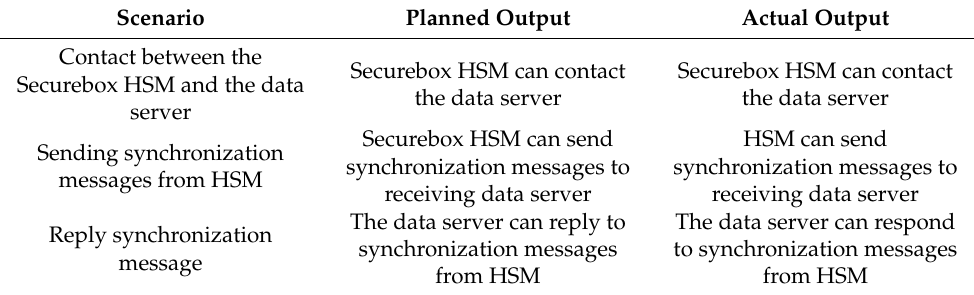
Table 3. Data synchronization functional testing.